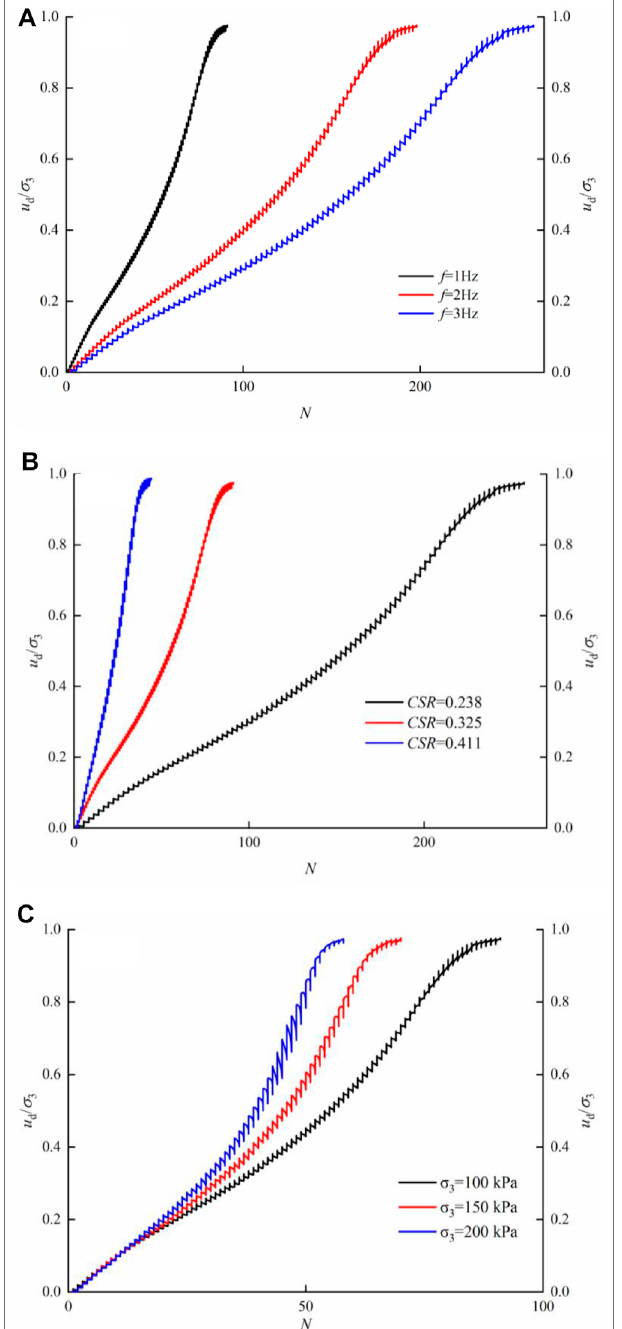
FIGURE 6 | Relations between u d / σ 3 and N under different frequencies (A) , cyclic shear stress ratios (B) and con fi ning pressures (C) .